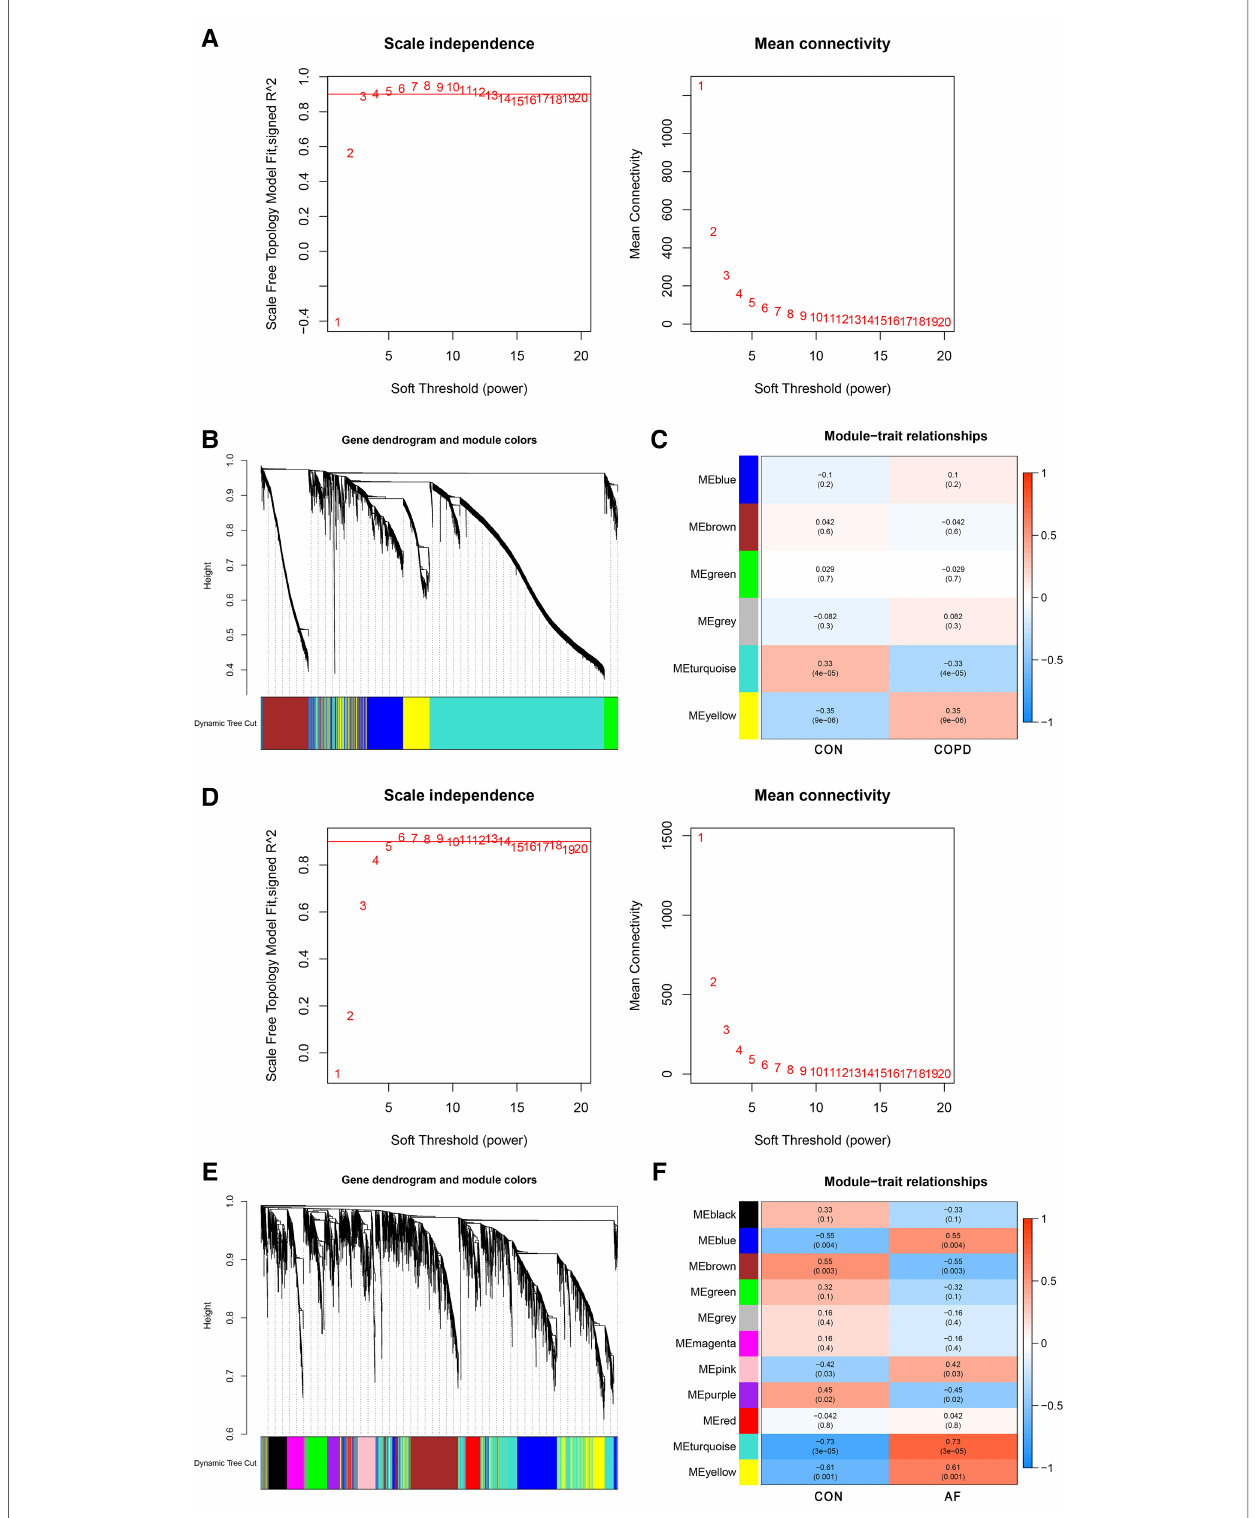
FIGURE 2 Identi fi cation of COPD and AF module genes via WGCNA. ( A ) The scale-free fi t index for soft-thresholding powers and mean connectivity (GSE76925). ( B ) Dendrogram of the genes clustered (GSE76925). ( C ) Module-trait relationships heatmap (GSE76925). The numbers in each cell means the correlation coef fi cient and p -value. ( D ) The scale-free fi t index for soft-thresholding powers and mean connectivity (GSE79768). ( E ) Dendrogram of the genes clustered (GSE79768). ( F ) Module-trait relationships heatmap